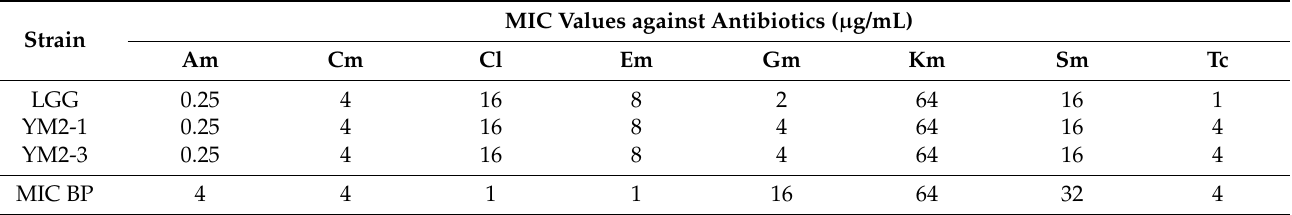
Table 3. Antibiotic susceptibilities of L. rhamnosus YM2-1, Y2-3, and